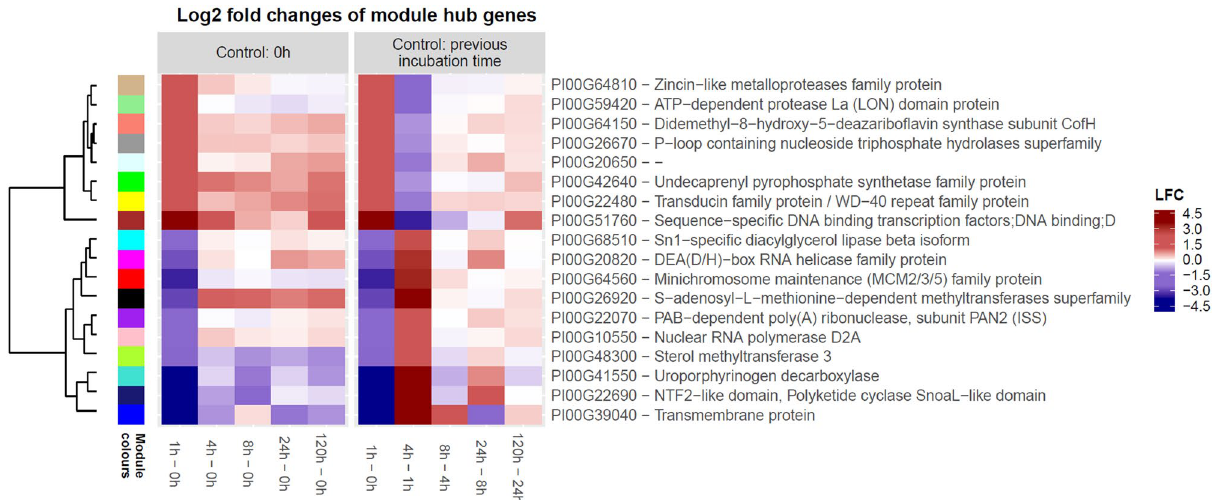
Figure 6. Module hub genes associated with processes affected by temperature stress in Picochlorum sp. (BPE23). Modules are defined from network inference by WGCNA of genes in the temperature-shock experiment. A heatmap represents differential expression levels of mRNA. Module color is displayed on the left. LFC represents the log2 fold